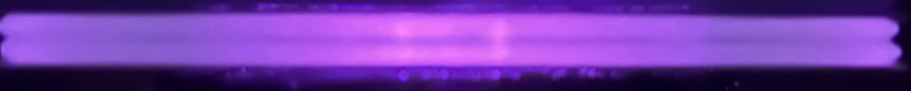
Figure 2. Image of the DBD plasma at 15 kV 100 Hz.